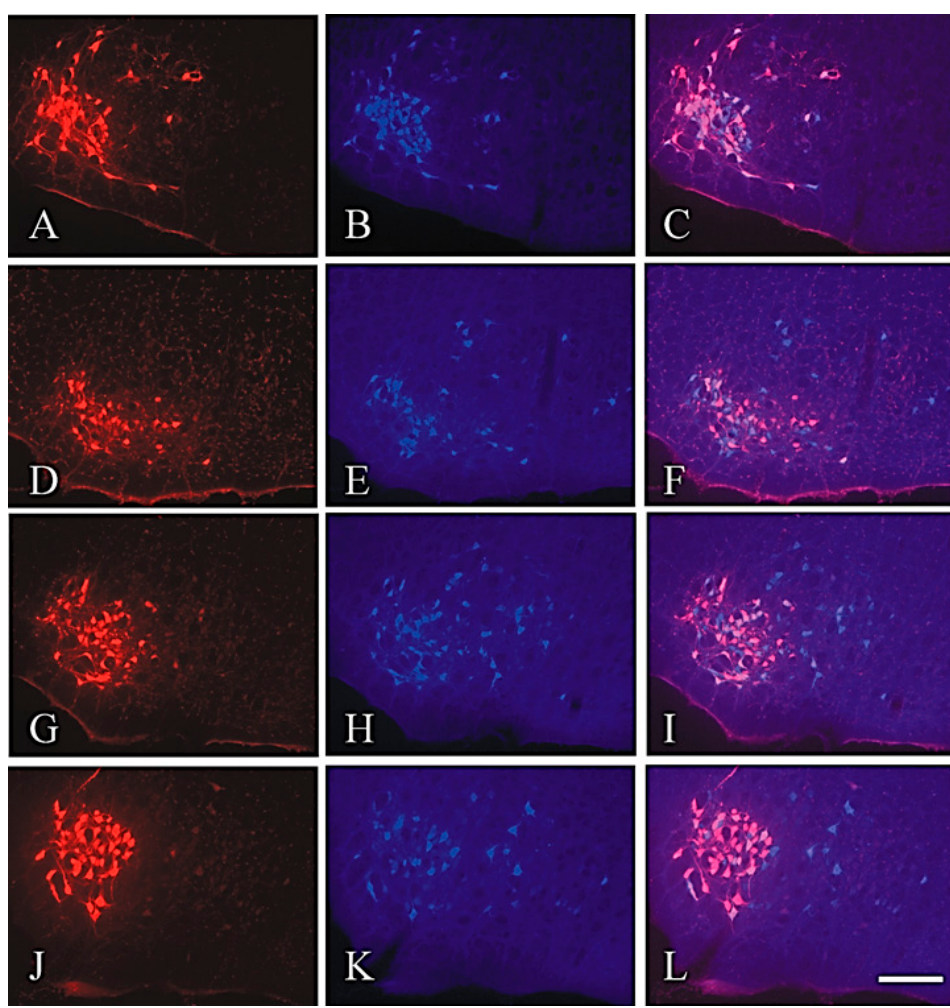
Figure 8. Rat brainstem 28 days after surgery on the buccal branch of the facial nerve (Bn). The lateral facial subnucleus, indicated by the pre-operative FG labelling, is in the left part of each picture. All photographs in the right column were produced by double exposure. ( A – C ) Intact facial nucleus with preserved myotopic organization of the motoneurons. Employing the selective filters, we depicted all pre-operatively FG-labelled ( A ) and all postoperatively FB-labelled ( B ) motoneurons. ( C ) In the intact facial nucleus, the proportion of double-labelled (FG + FB, pink to bright purple in colour) motoneurons is about 90%. ( D – F ) Lesioned facial nucleus 28 days after Bn-n. Whereas all preoperatively FG-labelled motoneurons are localized in the lateral facial subnucleus ( D ), those labelled postoperatively with FB are observed also in the intermediate facial subnucleus ( E ). Our quantitative estimates show that only about 27% of these FB-labelled motoneurons are double labelled ( F ) and belong to the original motoneuronal pool of the whisker pad. ( G – I ). Lesioned facial nucleus of a rat 28 days after Bn-n + IOn-ipsi-ex. All preoperatively FG-labelled motoneurons are in the lateral facial subnucleus ( G ). The postoperatively FB-labelled motoneurons are found in the lateral and intermediate facial subnuclei ( H ). The double-exposure picture ( I ) is similar to that in F, showing that about 32% of the FB-labelled cells were also FG labelled. ( J – L ). Lesioned facial nucleus of rat 28 days after Bn-n +IOn-contra-ex. All preoperatively FG-labelled motoneurons are in the lateral facial subnucleus ( J ) and some postoperatively FB-labelled cells are found in the intermediate facial subnucleus ( K ). Our counts show that after this type of combined surgery, the proportion of the double-labelled motoneurons ( L ) increased significantly to 41%. 50 µ m thick vibratome sections; the scale bar indicates 100 µ m. From Skouras et al. (2002)